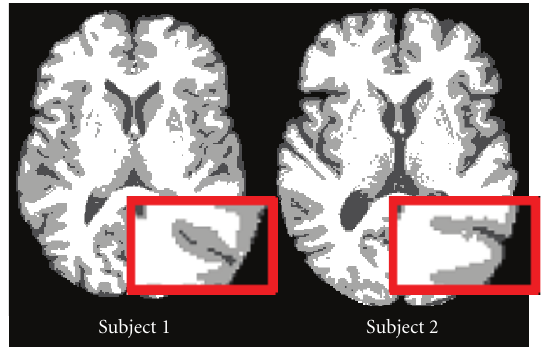
Figure 2: The hard segmentation of two di ff erent